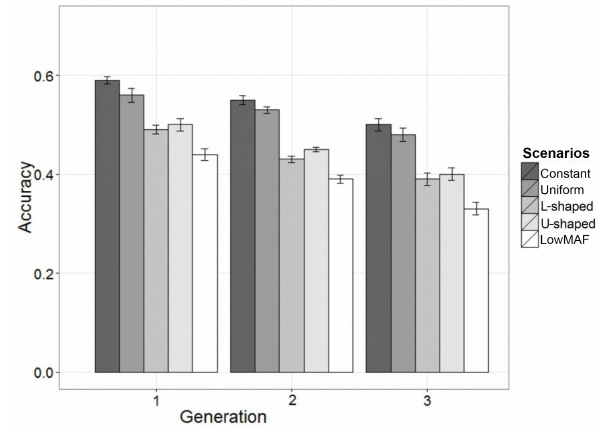
Figure 2. Accuracy of genomic estimated breeding values using genomic best linear unbiased prediction for different distributions of the QTL allele frequency. The whiskers represent 95% asymptotic confidence